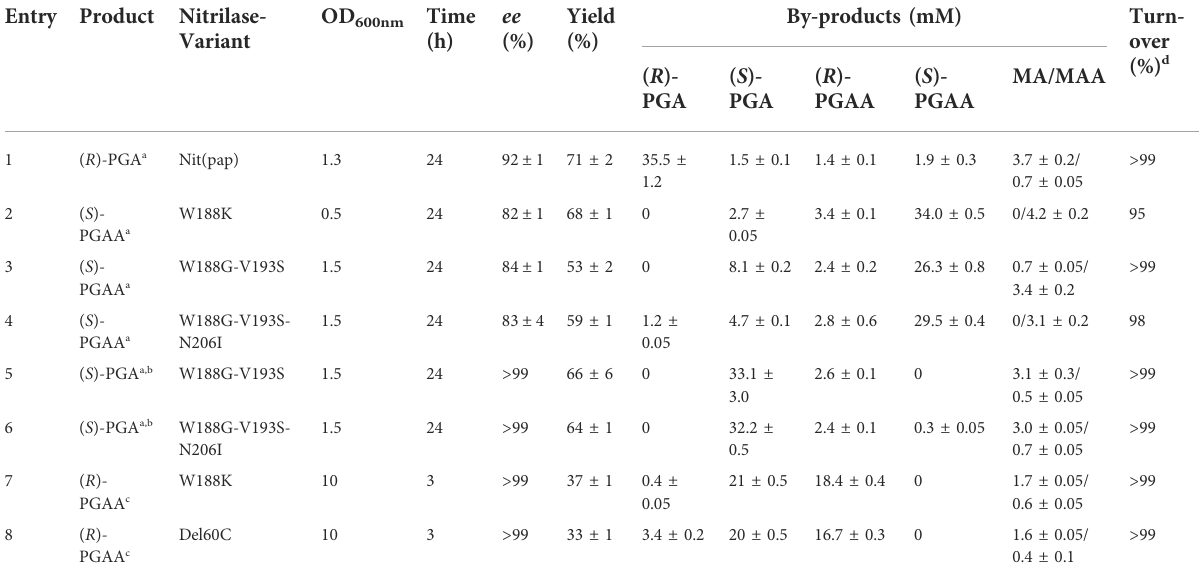
TABLE3Enantioselectivesynthesisof( R )-and( S )-phenylglycineand( R )-and( S )-phenylglycinamidefrombenzaldehyde,KCNandammoniabyusing different variants of the nitrilase from P. fl uorescens EBC191. Entry Product Nitrilase-